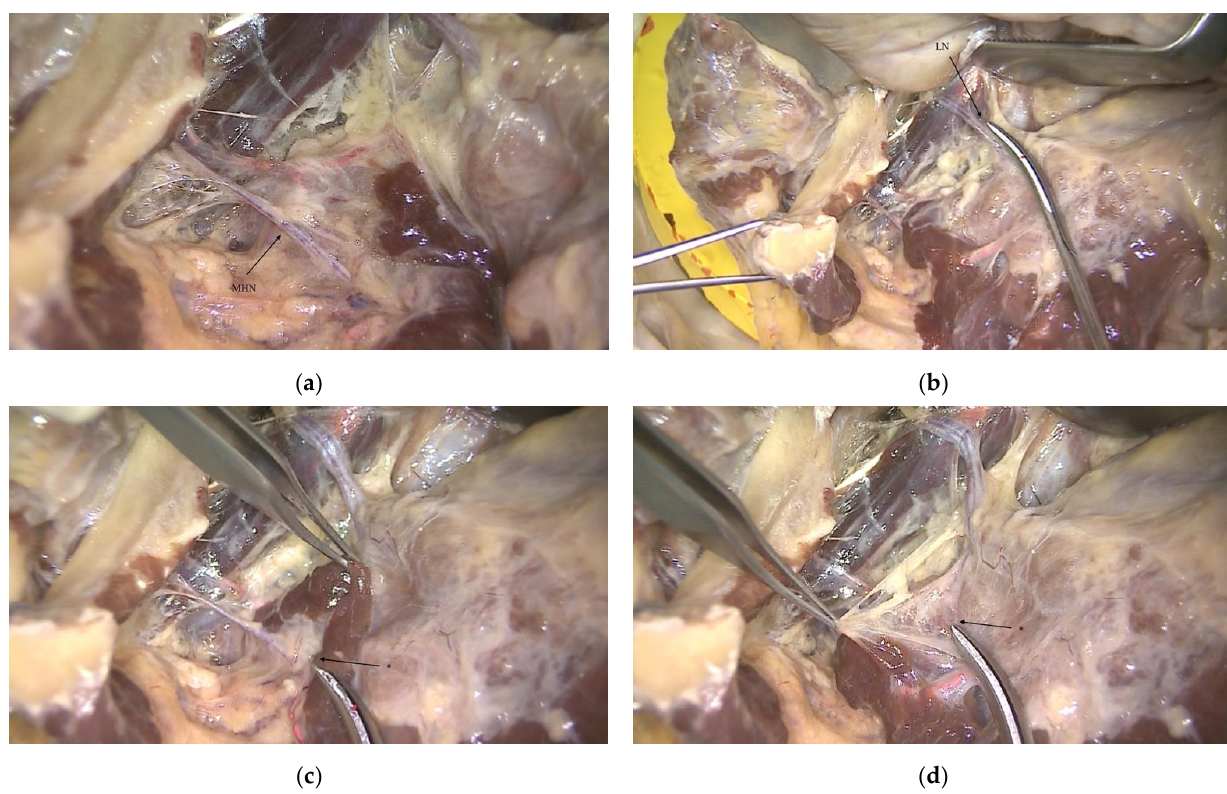
Figure 5. Anatomical pictures of a human body dissection, from which it is possible to better understand the intimate relation between the lingual nerve and the nerve to the mylohyoid: (a) nerve to the mylohyoid (MHN), (b) lingual nerve (LN), (c) (d) anastomosis between nerve to the mylohyoid and lingual nerve (*).